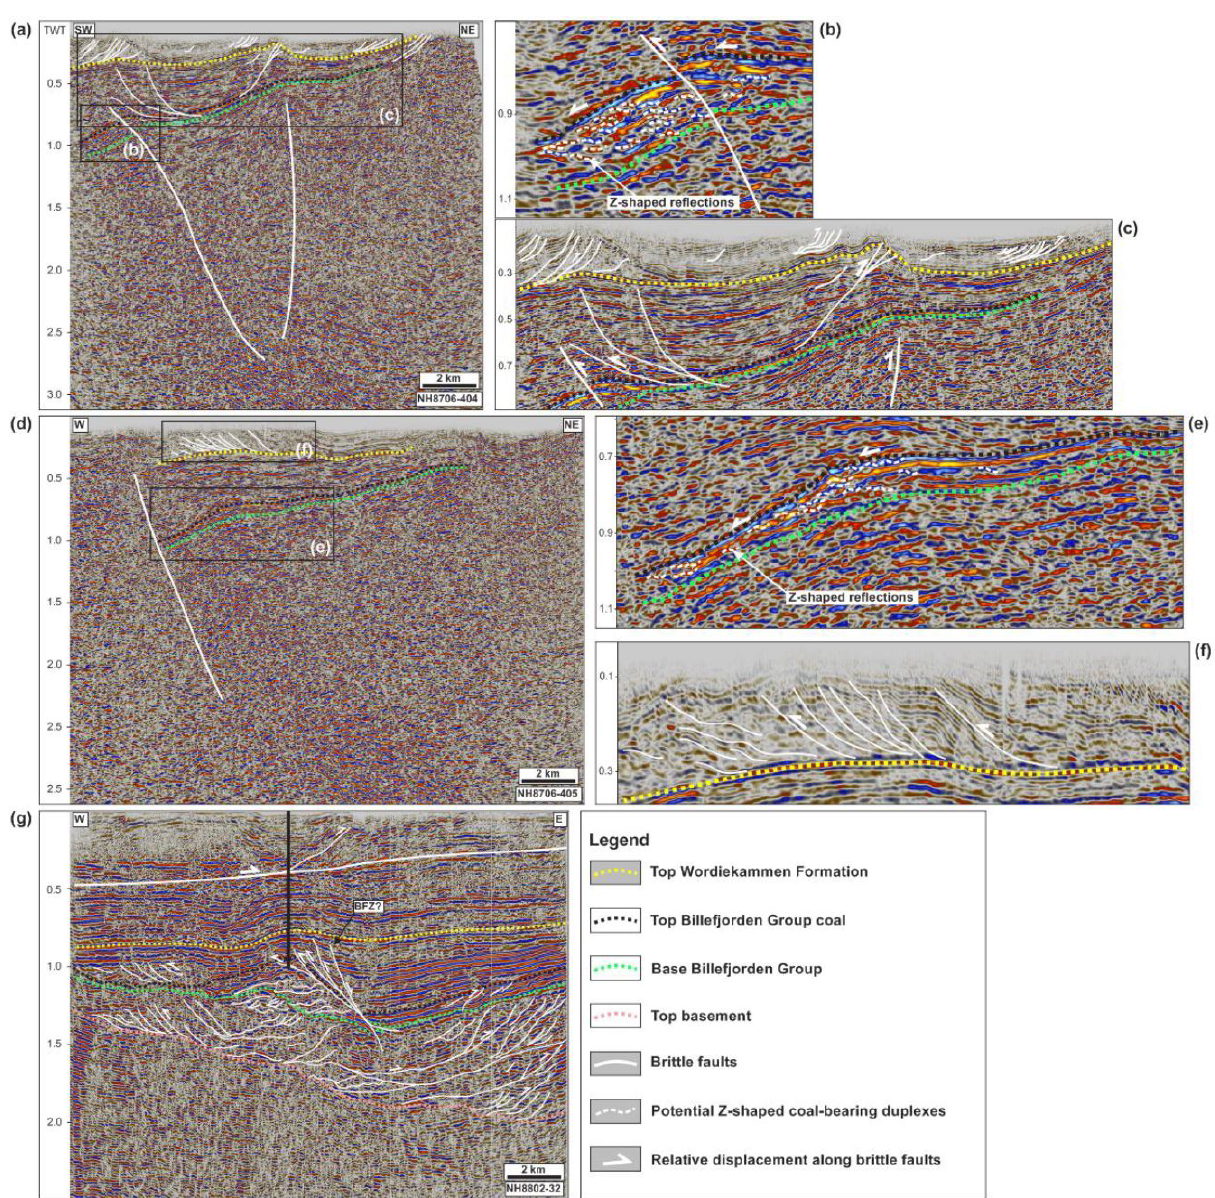
Figure 5. Seismic sections in two-way time (TWT) and associated zoomed-in portions in Saassenfjorden–Tempelfjorden (a–f) and Rein- dalspasset (g) . See Fig. 1b for locations. (a) NE–SW-trending section showing minor reverse offset and fault-propagation folding in thickened uppermost Devonian–Mississippian sedimentary rocks along WNW–ESE- to NW–SE-striking, deep-seated basement faults, and Eurekan thrusts in overlying Pennsylvanian–Permian strata. (b) Close-up of SW-verging, coal-bearing duplexes acting as top-SW Eurekan décolle- ments in thickened, uppermost Devonian–Mississippian sedimentary deposits. (c) Close-up of NW–SE-striking Eurekan thrusts that flatten into décollements within uppermost Devonian–Mississippian coals and at the top of the Wordiekammen Formation. (d) NE–west-trending, arch-shaped section showing the potential continuation of the Billefjorden Fault Zone bounding thick uppermost Devonian–Permian sedi- mentary deposits and top-west Eurekan thrusts within lower Permian rocks. (e) Close-up of coal-bearing duplexes in uppermost Devonian– Mississippian sedimentary strata indicating top-west early Cenozoic movement. (f) Close-up of Eurekan thrusts flattening into a décollement near the top of the Wordiekammen Formation. (g) West–east-trending section showing a top-east Eurekan detachment in Mesozoic sedimen- tary rocks and a broad anticline in Devonian–Permian strata. Shale-rich Devonian–Mississippian sedimentary strata thicken into the anticline whereas Pennsylvanian–Permian sedimentary rocks thicken away from the anticline. The former are truncated by numerous early Cenozoic Eurekan thrusts arranged into duplex-like structures that flatten into intra-Devonian–Mississippian décollements. Note that the thick vertical black line represents the location of exploration well 7816/12-1 (total depth: 2261m; Eide et al., 1991). Abbreviation – BFZ: Billefjorden Fault